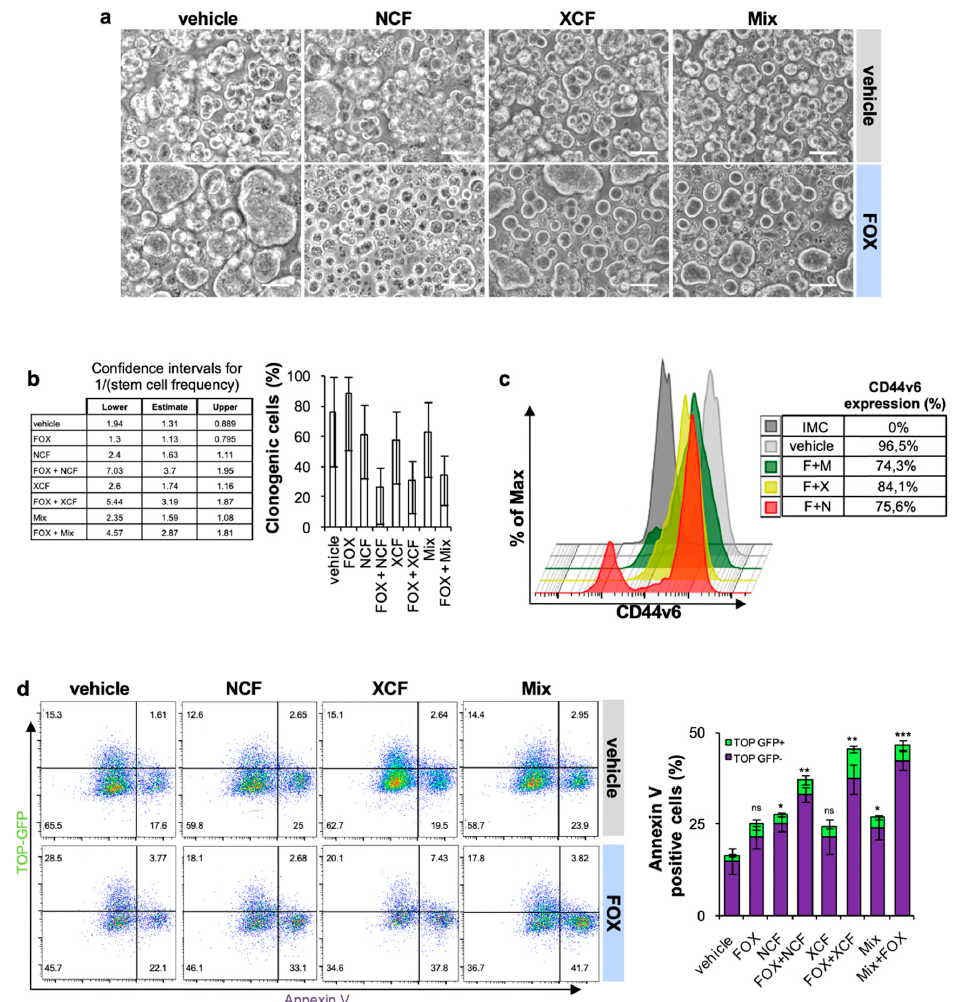
Figure 4. Flavonoids extracts plus chemotherapy decreased the stemness features of CR-CSphC. ( a ) Phase contrast image showing the sphere forming capability of CR-CSphCs treated with 0.5 µM FOX in combination with 12.5 µg/mL NCF, XCF, or both extracts (Mix), for 48 h; ( b ) clonogenic capability, evaluated by ELDA software, of CR-CSphCs. Pre-treated for 48 h as in ( a ); ( c ) representative flow cytometry analysis of CD44v6 expression on CR-CSCs following 48 h treatment as in ( a ); ( d ) representative flow cytometry analysis of Annexin V on CR-CSphCs (#8) transduced with TOP-GFP and treated as in A (left panel) and relative percentage of Annexin V positive CR-CSphCs (#8) (right panel). Data are expressed as mean ± SD of three independent experiments. Comparisons between two groups were made using a two-tailed Student’s t -test: ns, not significant, * p ≤ 0.05, ** p ≤ 0.01, *** p ≤ 0.001.